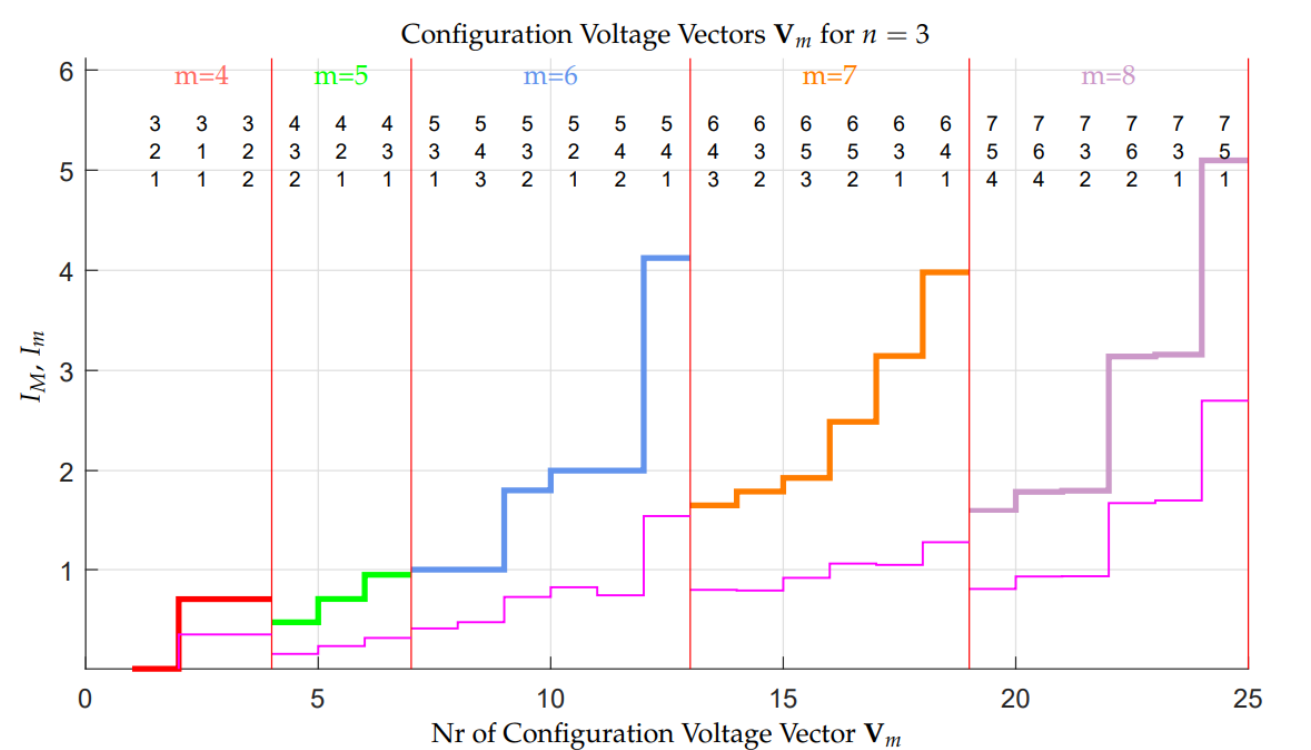
Figure 18. Configuration Voltage Vectors V m , for n = 3, sorted in ascending order with respect to the Divergence Index I M